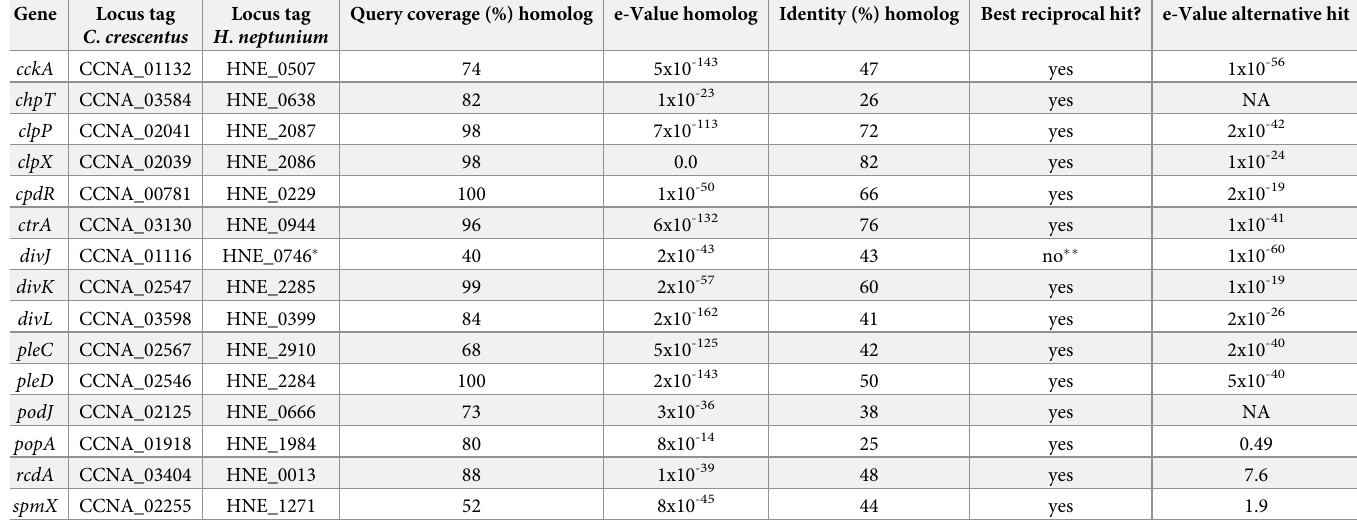
Table 1. H . neptunium homologs of cell cycle-related genes from C . crescentus . The table summarizes the query coverage, e-value and degree of identity for the best hits in H . neptunium obtained in BLAST searches with the respective proteins from C . crescentus as a query. The e-values of the respective second-best hits are given for comparison. The information in the column ‘Best reciprocal hit?’ indicates whether the indicated C . crescentus protein is the best hit in a BLAST search performed with the respective H . neptunium homolog as a query. NA indicates that no further hits were detected. Gene Locus